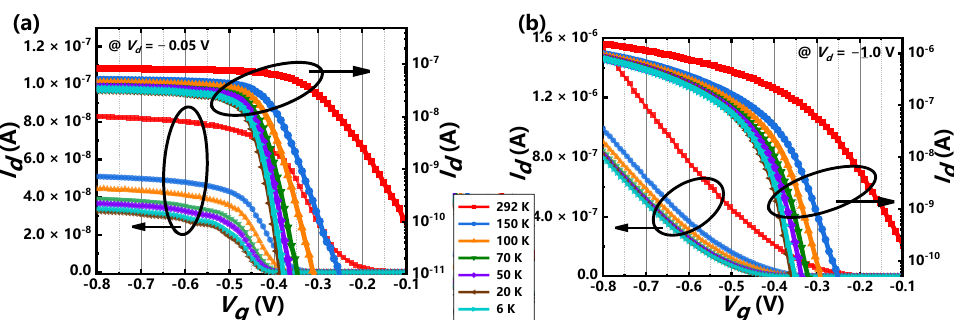
Figure 2. Measured linear and logarithmic I d – V g curves at different temperatures ranging from 6 K to 292 K at ( a ) V d = − 0.05 V and ( b ) V d = − 1 V.